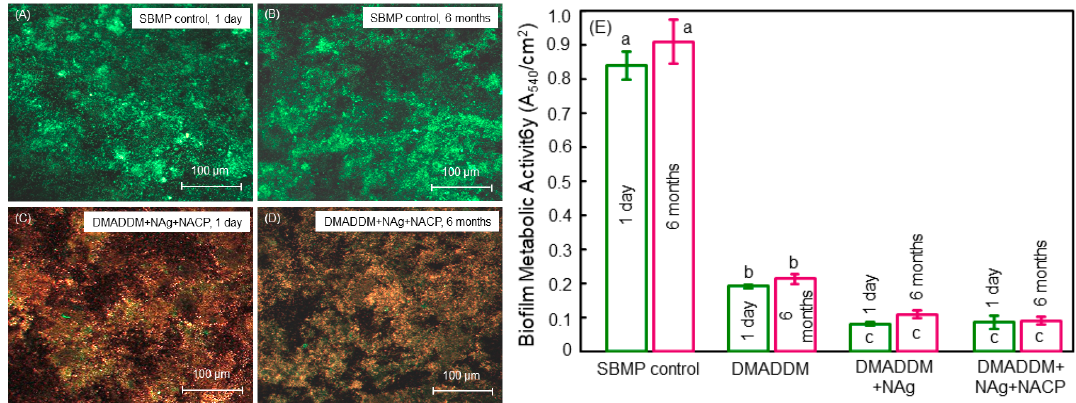
Figure 4. Anti-biofilm bonding resin after water-aging for 6 months. ( A , B ) Typical confocal laser scanning microscopy live/dead images for SBMP control; ( C , D ) DMADDM + Nag + NACP, at one ( C , D ) (not shown). The novel bioactive bonding agent had primarily compromised bacteria.